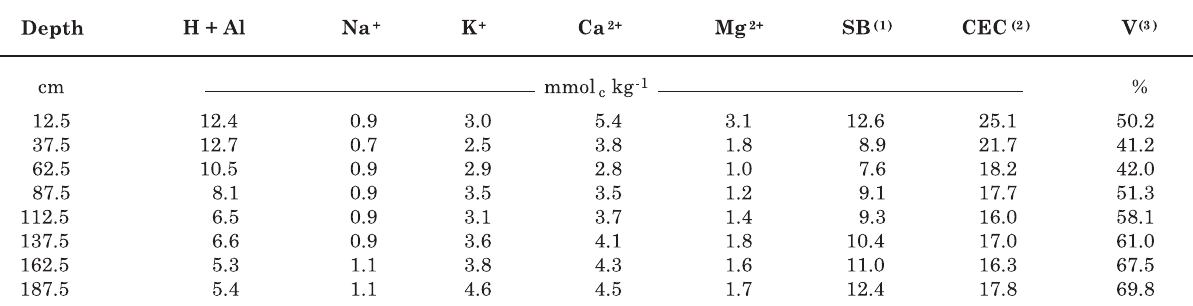
Table 3. Soil chemical properties before experiment, from 0 to 200 cm soil depth